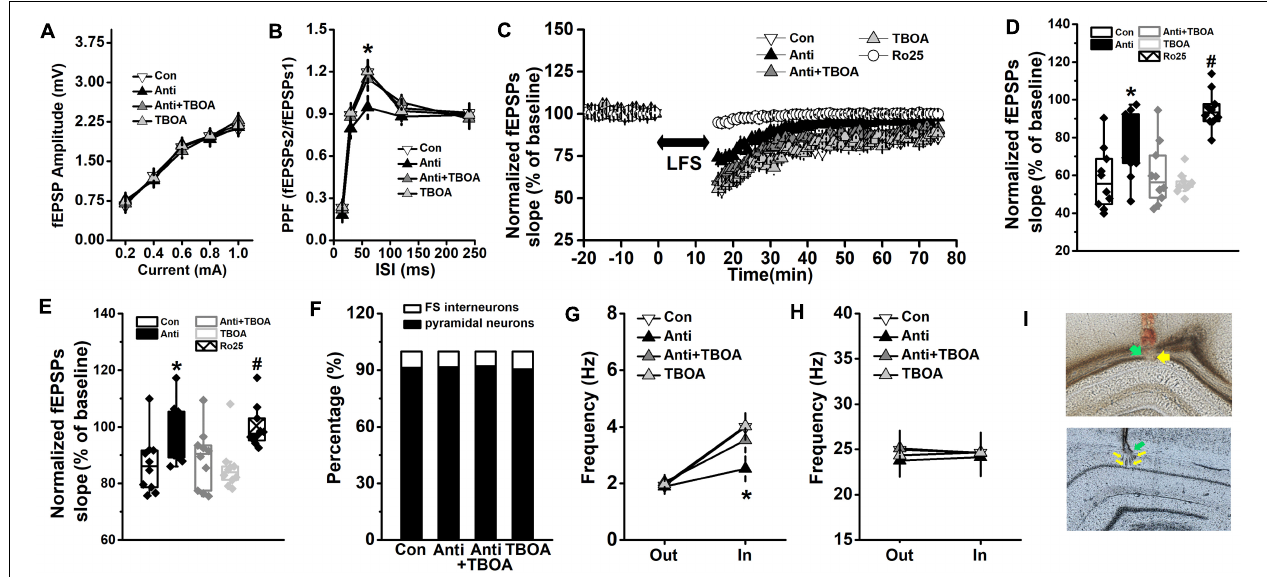
FIGURE 5 | GluN2B-dependent neural function is enhanced by TBOA. The Anti group was bilaterally infused with anti-proBDNF antibody into the CA1 region throughout the whole PD4w, whereas the Con group received the same volume of ACSF. Eight-week-old rats were selected for detecting hippocampal synaptic function in the Schaffer collateral-CA1 pathway immediately following TBOA (Anti+TBOA and TBOA groups), Ro25 (Ro25 group), or ACSF (Con and Anti groups) injection. (A) Input–output curves of fEPSP slopes. (B) PPF, a form of short-term plasticity, was measured and expressed as the ratio of fEPSPs2 to fEPSPs1. (* p < 0.05, Anti vs. other groups). (C) Characteristic time courses of fEPSP slope. Arrow represented application of LFS. (D) The effects on PTD, which was determined as response 1 min after LFS. (* p < 0.05, Anti vs. other groups; # p < 0.05, Ro25 vs. other groups) (E) Time coursing changes in fEPSPs slope. Magnitude of SL-LTD was determined as responses in the last 20 min (between 56 and 75 min). (* p < 0.05, Anti vs. other groups; # p < 0.05, Ro25 vs. other groups). n = 10 per group. When rats were tested in the probe trial that was conducted 24 h following the last training trial, neural activity around the target platform area was recorded. TBOA (Anti+TBOA and TBOA groups) or ACSF (Con and Anti groups) infusion was conducted 30 min prior to the behavioral test. (F) The proportion of pyramidal neuron and FS interneuron. (G) Firing rate of pyramidal neurons out of target area (Out) and around the targeted platform (In) during the probe test. (H) Firing rate of FS interneuron out of target area (Out) and around the targeted platform (In) during the probe test. (* p < 0.05, Anti vs. other groups). n = 10 per group. (I) The histological representations of the recording sites during the fEPSPs (top) and neuronal activity (bottom) experiments. The green and yellow arrows indicate infusion site and recording site,